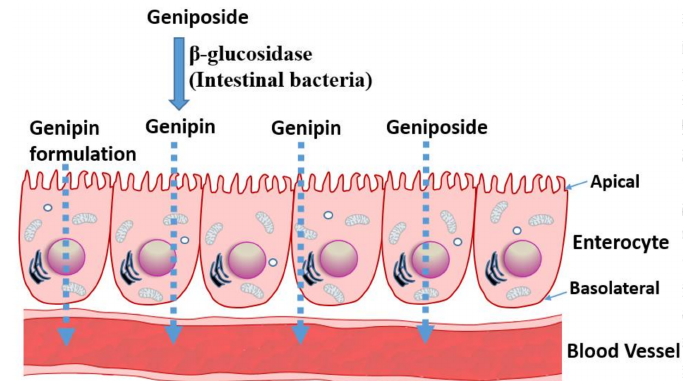
Figure 2. Transport mechanisms of geniposide and genipin. The absorption of geniposide, which is predominantly present in plant extracts, could be enhanced by transformation in the gut through the action of bacterial β -glucosidase enzymes. Other preparations, such as borneaol or crude plant extracts, could increase the absorption from the gut. The bioactive molecule, genipin, is highly non-polar and water insoluble, and a formulation strategy is required to maximize its